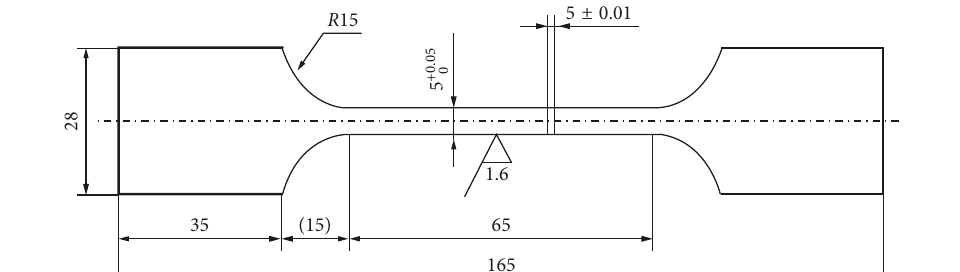
Figure 21: Test specimen design dimension.